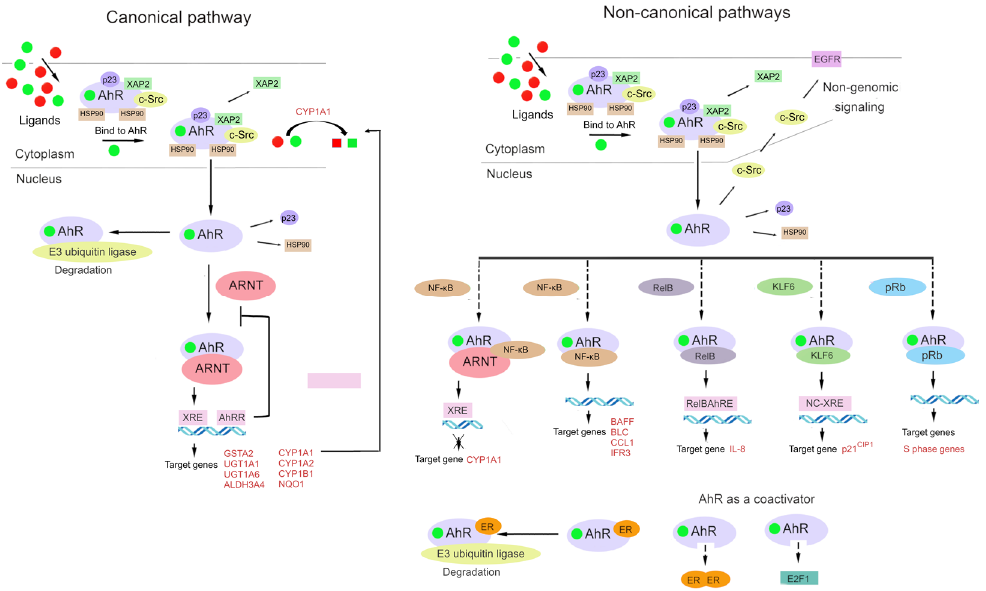
Figure 2. An outline of canonical and non-canonical AhR signaling pathways. Under physiological conditions, AhR is localized to the cytosol and forms a complex with specific proteins, such as hepatitis B virus X-associated protein 2 (XAP-2), heat shock protein 90 (HSP90), cytosolic endoplasmic- reticulum proteins, and protein tyrosine kinase c-Src. After binding to a ligand, AhR changes its conformation and relocates to the nucleus, where it dimerizes with AhR nuclear transporter (ARNT) or other partners such as transcription factor Krüppel-like factor 6 (KLF6) or transcription factors of the nuclear factor kappa B (NF-κB) family (e.g., RelB). Dissociated c-Src interacts with epidermal growth factor receptor (EGFR). AhR signaling is connected with the activity and function of estrogen receptor and E2 promoter-binding factor 1 (E2F1), which is capable of binding to pRB. The AhR– ARNT complex binds to a xenobiotic-responsive element (XRE) and induces the transcription of AhR-controlled genes. Proteins AhR and KLF6 form a heterodimer that recognizes a novel non- consensus XRE (NC-XRE) and initiates the transcription of genes involved in cell cycle regulation. Proteins AhR and RelB (an NF-κB subunit) combine into a heterodimer that recognizes a RelB–XRE complex and induces the transcription of some chemokine genes. AhR and NF-κB form a heterodimer that lead to the inducing of the expression of cytokines and chemokines B-cell-activating factor of the tumor necrosis factor family (BAFF), B-lymphocyte chemoattractant (BLC), CC-chemokine ligand 1 (CCL1), and interferon-responsive factor (IFR3). The AhR/ARNT/NF-κB interaction decreases the expression of CYP1A1. AhR and pRb form a heterodimer that lead to a blocked cell cycle progression by suppressing the expression of S-phase genes. AhR activity is controlled by negative feedback loops, including the metabolism of ligands, the disruption of the AhR/ARNT complex by AhR repressor (AhRR), and proteosomal degradation by the ubiquitin ligase complex. AhR in complex with ER promotes the proteolysis of ER by ubiquitin ligase complex.